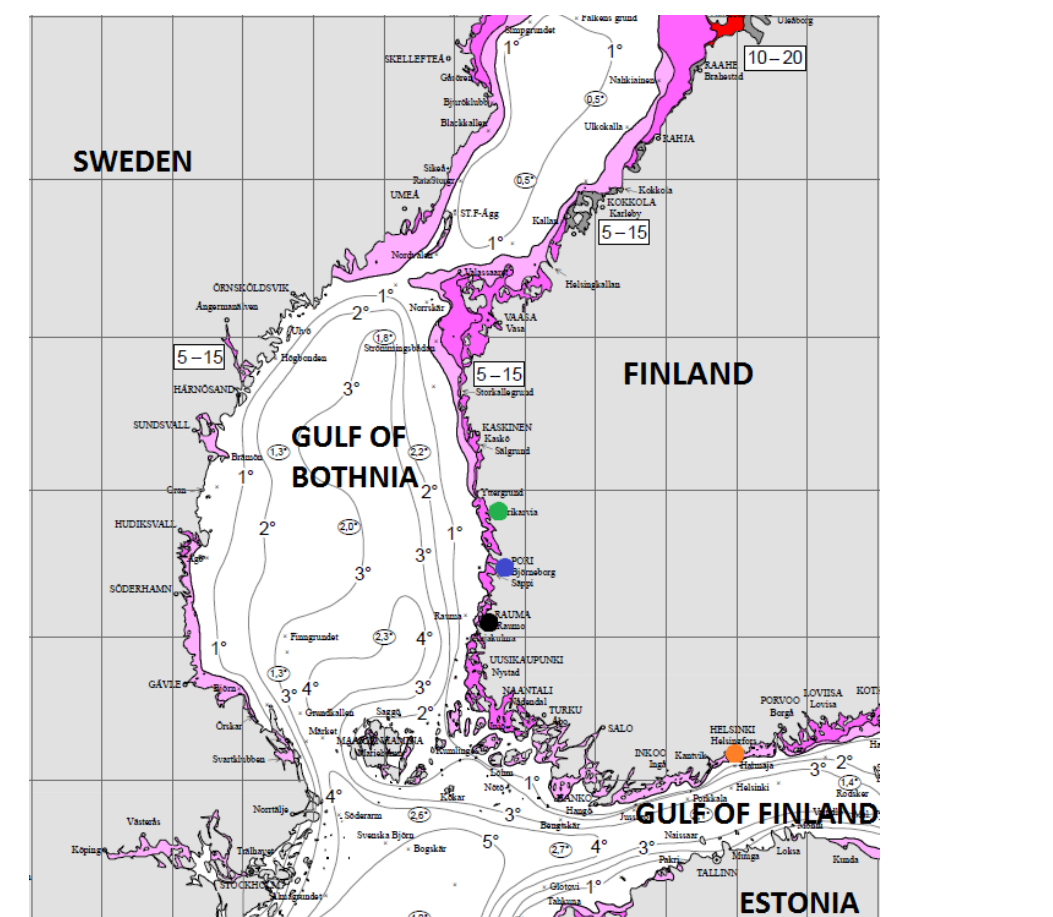
Figure 2. Ice chart on 8 January 2016. Water temperature isotherms are shown with black solid lines along with the sea surface mean temperatures (1971–2000) encircled. Purple/red shades indicate different ice formations (new ice, grey ice, very close ice). Ice thickness is shown in squares (cm). Merikarvia is marked with a green dot, Pori with a blue dot, Rauma with a black dot, and Helsinki with an orange